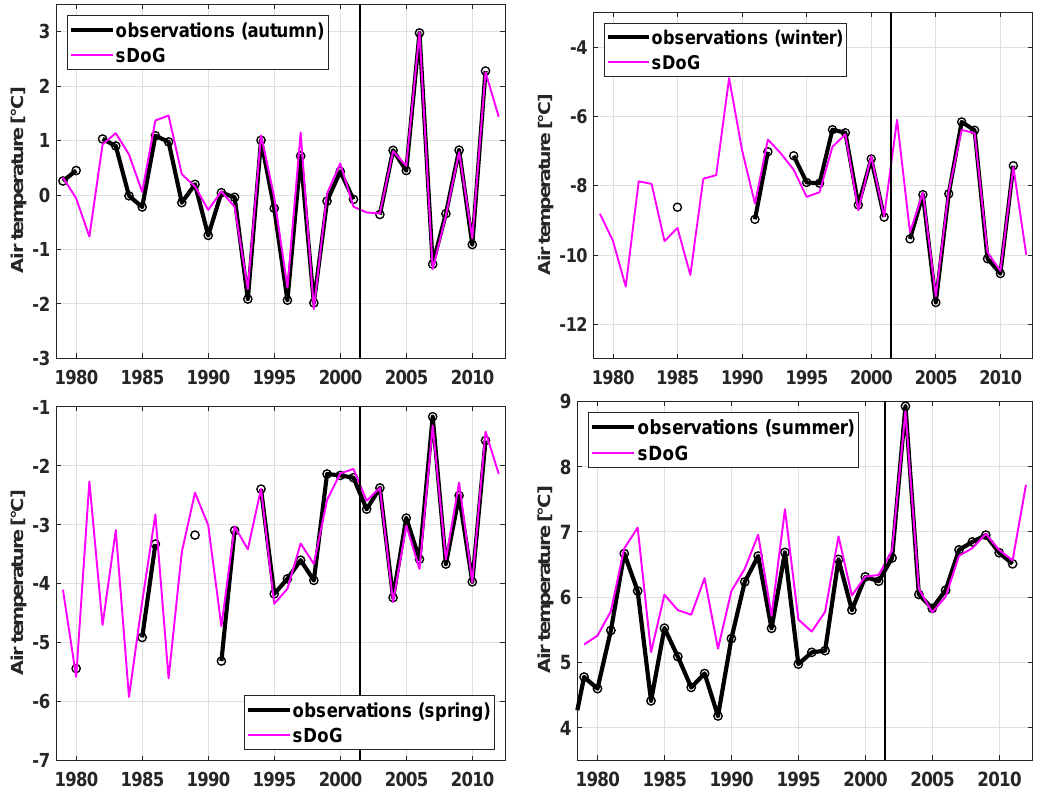
Figure 4. Seasonal mean air temperature at VERNAGT from 1979 to 2012, observations (black line with circles) and sDoG (magenta). Autumn (SON) air temperatures are shown in the top left panel, winter (DJF) in the top right panel, spring (MAM) in the bottom left panel and summer (JJA) in the bottom right panel. The black vertical line separates the evaluation period, obs-trueval (1979 to 2001) from the training period, obs-training (2002 to 2012). Note that while autumn ( top left ) and summer ( bottom right ) temperatures show almost complete records, winter ( top right ) and spring ( bottom left ) air temperatures are affected by missing data particularly prior to